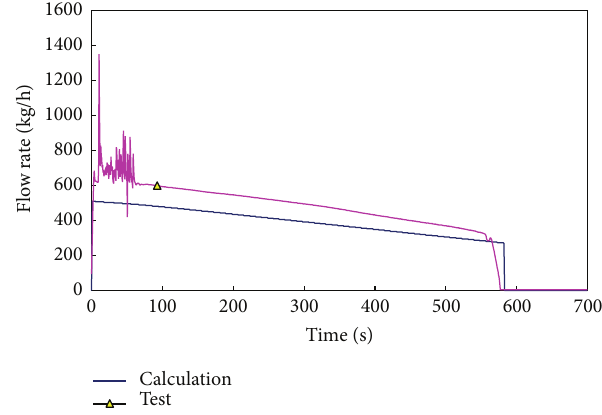
Figure 12: The flow rate comparison between calculation and